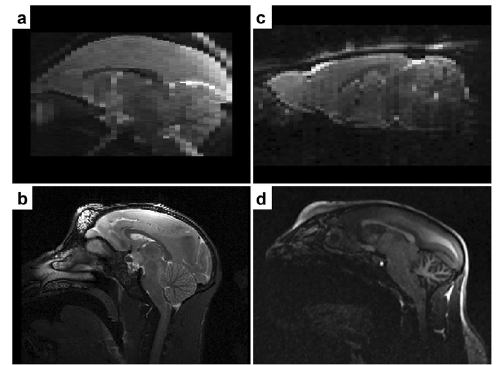
Figure 1. Challenges in skull-stripping animal MR-neuroimaging. Illustration of common difficulties when skull-stripping animal MRI (top-left: marmoset [9.4 T Biospec, Bruker, Germany]; top-right: rat [9.4 T Biospec, Bruker, Germany]; bottom-left: rhesus macaque [3 T Prisma, Siemens, Germany]; bottom-right: marmoset [3 T Prisma, Siemens, Germany]), such as low image resolution ( a , c ), strong field inhomogeneity ( a – d ) or greater field-of-view ( b,d ) with larger areas of non-brain